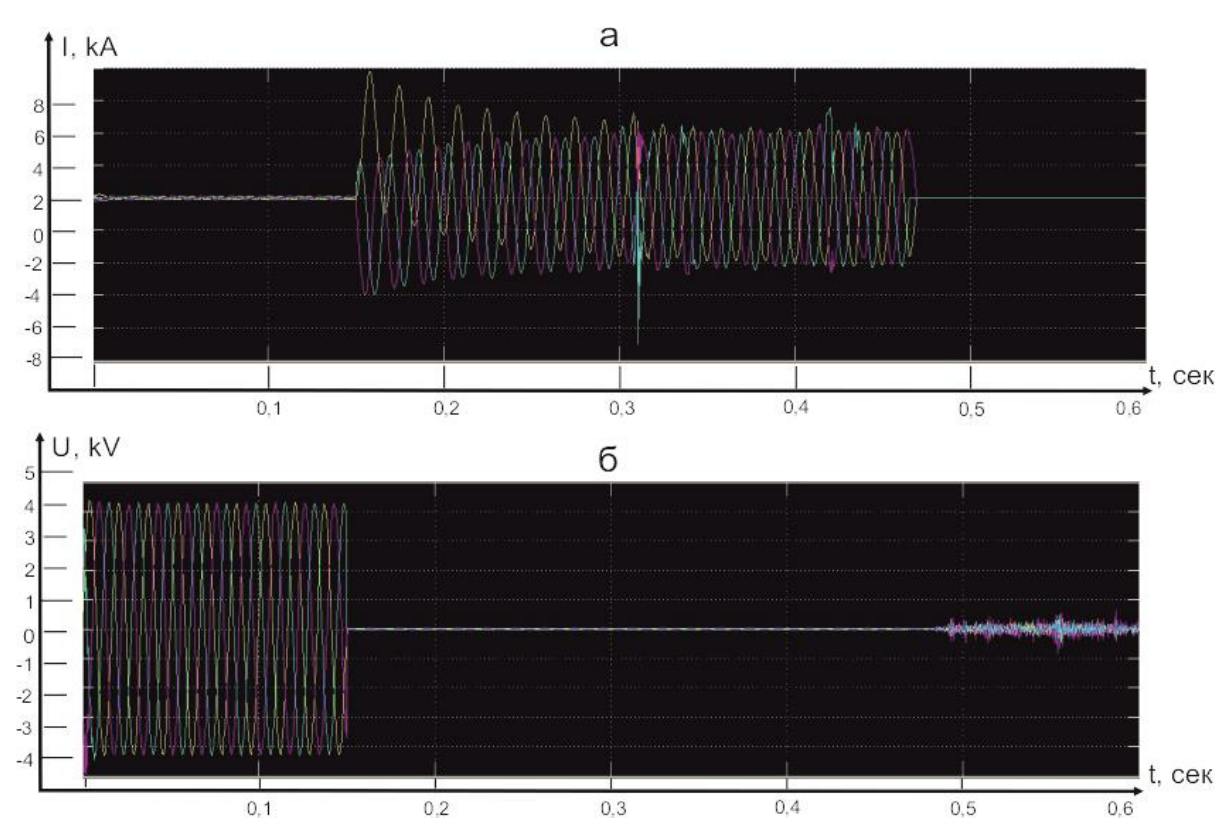
Figure 6. Oscillogram of current (a) in three phase fault (b) voltage depression of the network on 10